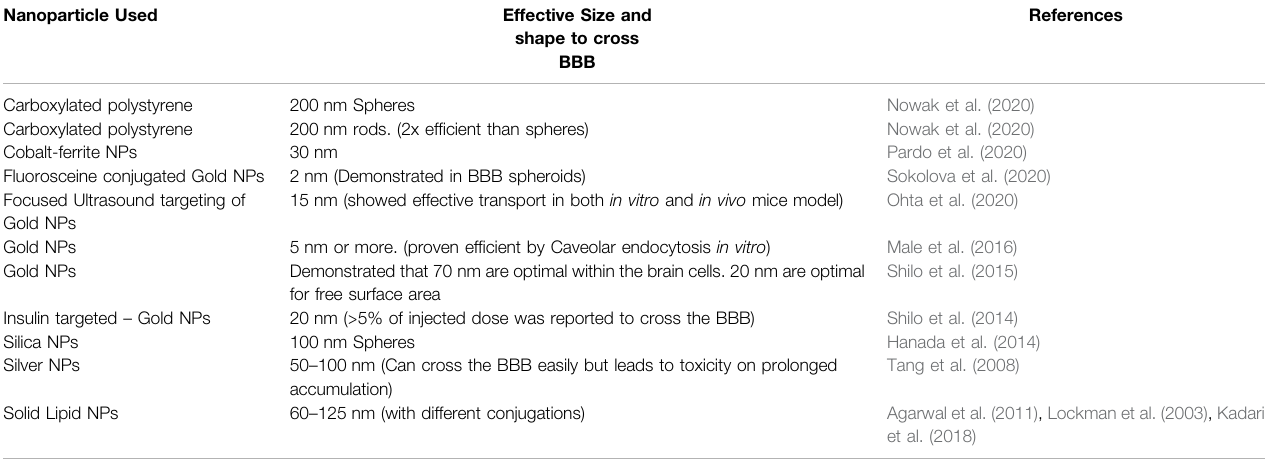
TABLE 2 | Recent works demonstrating Effective Nanoparticle sizes to cross